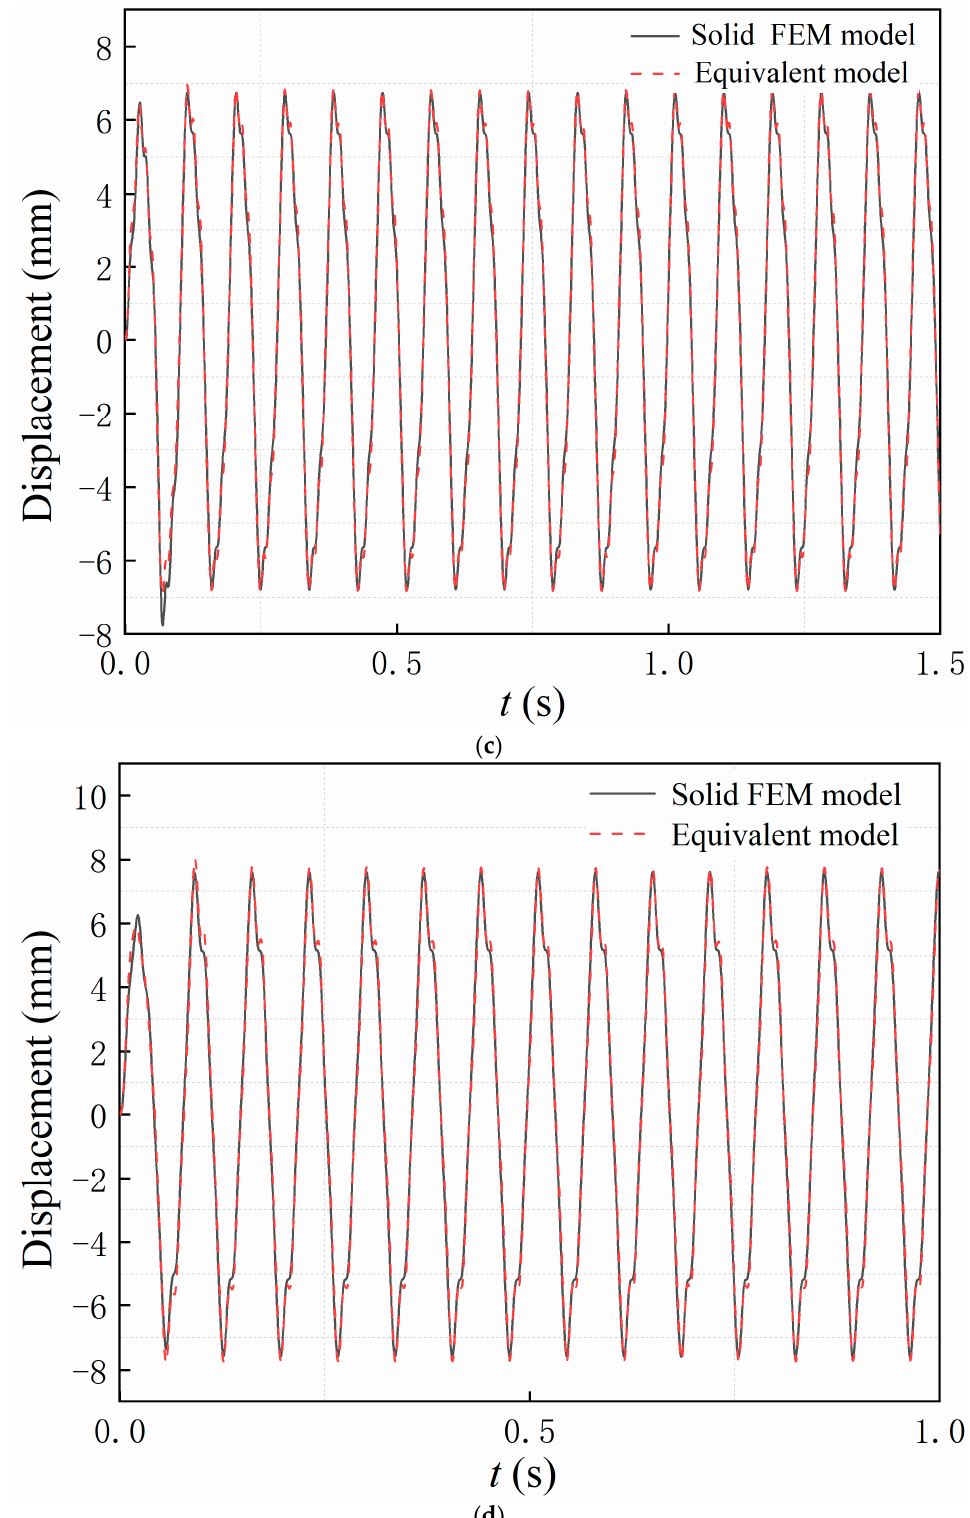
Figure 18. Responses of the equivalent model and the solid FEM model under different excitation frequency: ( a ) ω = 30 rad/s; ( b ) ω = 50 rad/s; ( c ) ω = 70 rad/s; ( d ) ω = 90 rad/s.